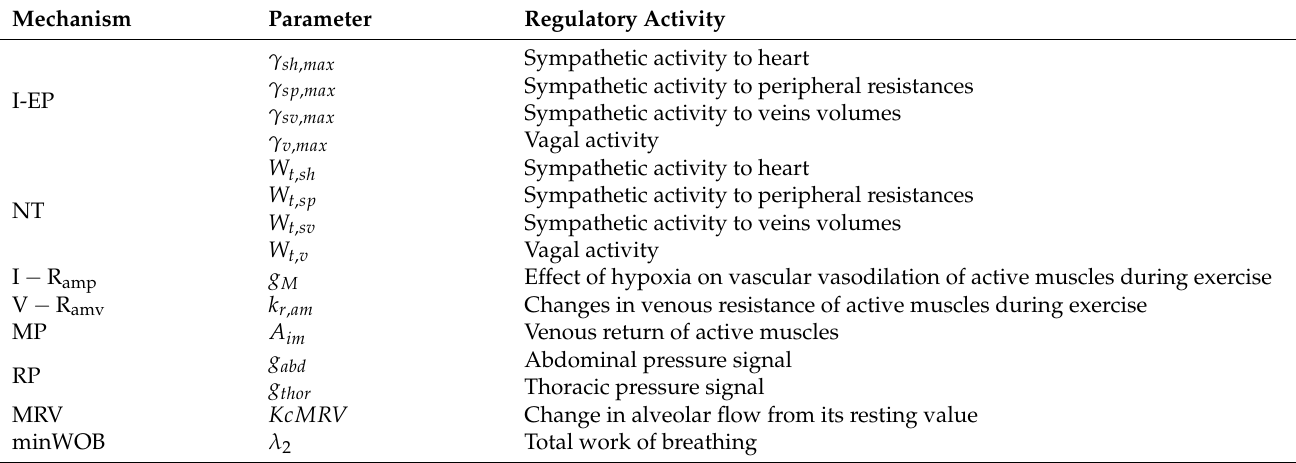
Table 3. Selected parameters for stimulus-related fitting.